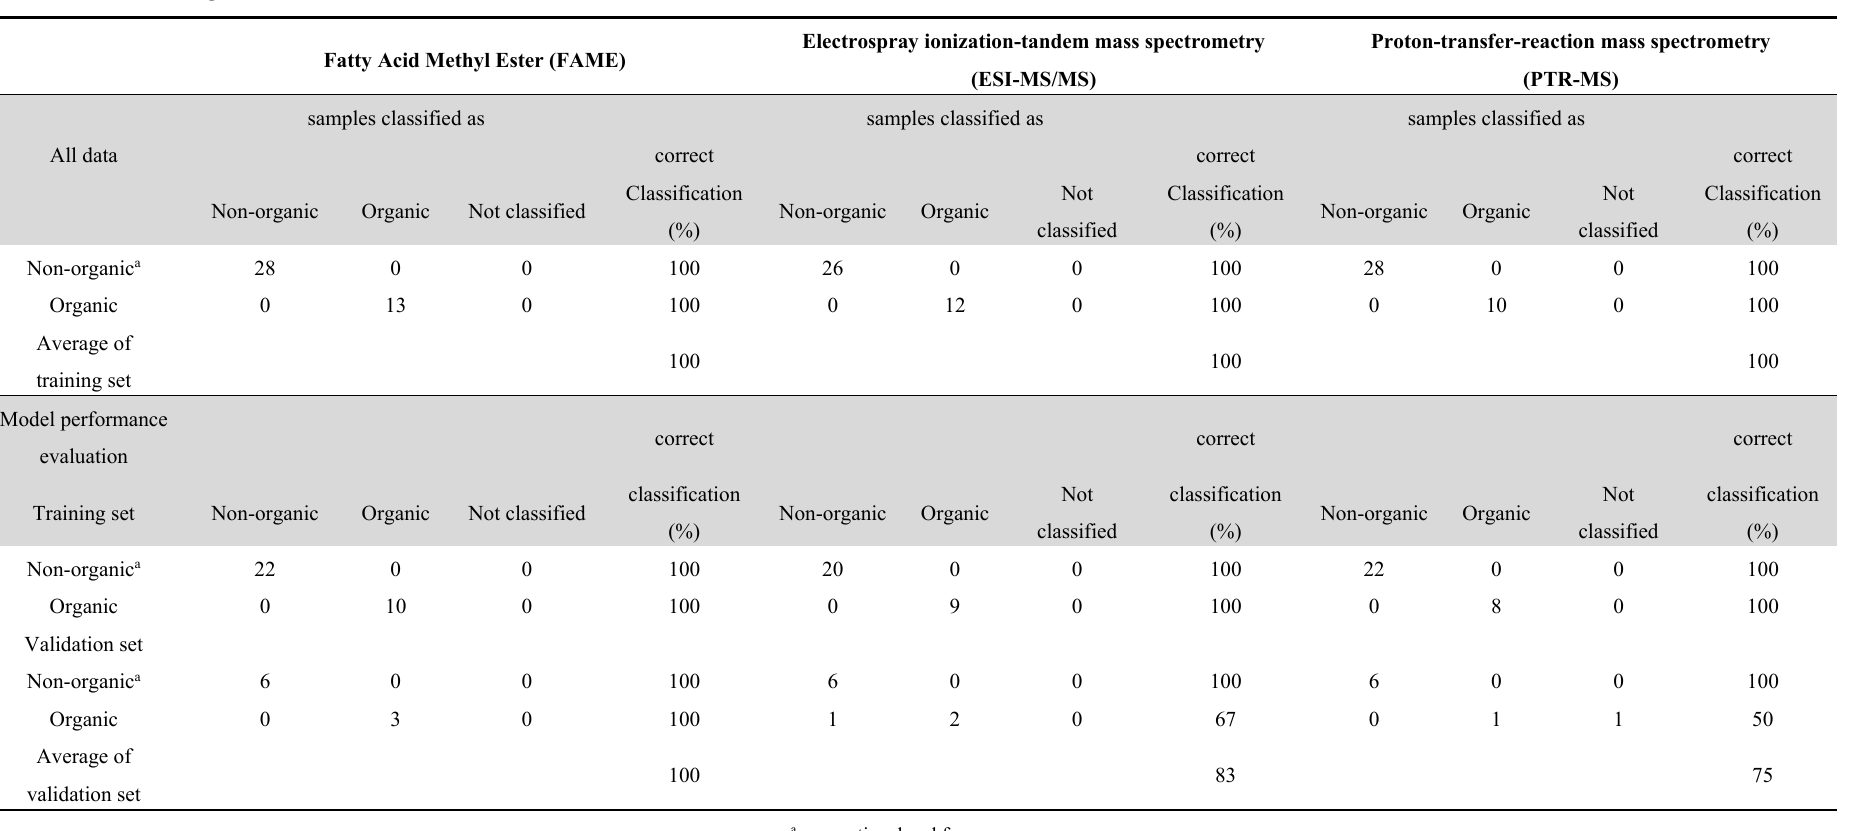
Table 3. Percentage of samples of pork belly meat from the categories non-organic (conventional + free range) and organic correctly classified in the training set of the SIMCA